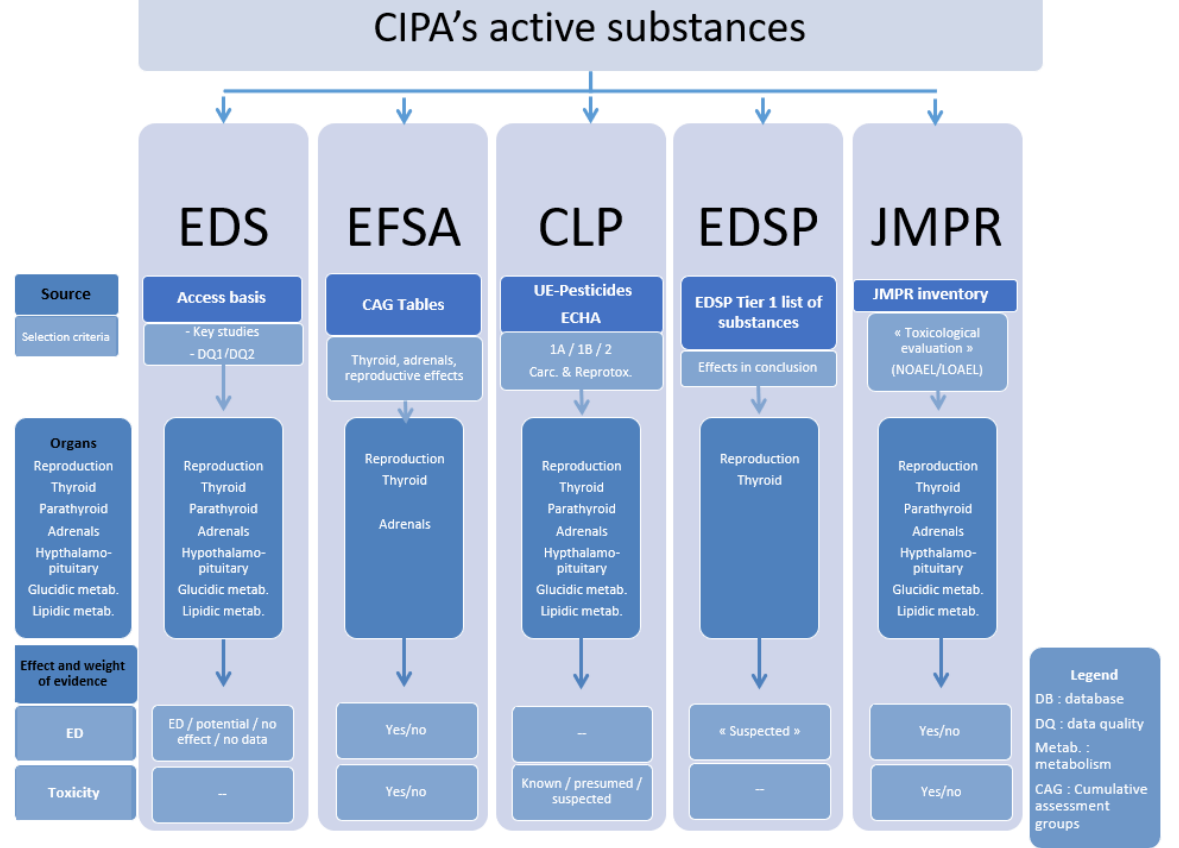
Figure 1. Summary of the endocrine disruptors, toxic effects, and target organs covered by the five databases used in this study.